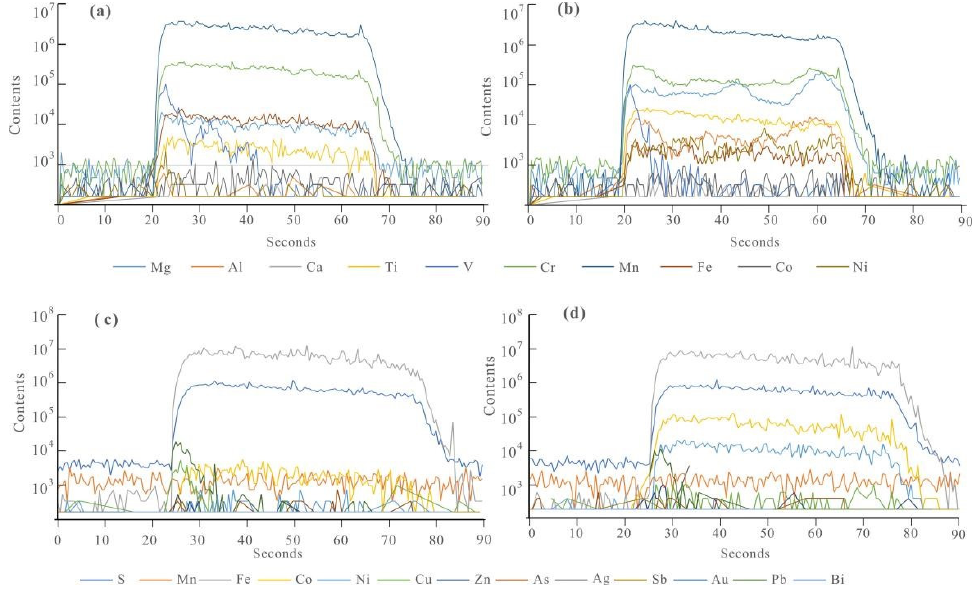
Figure 7. Representative time-resolved analytical signals of LA-ICP-MS analyses. ( a , b ) Magnetite; ( c , d )